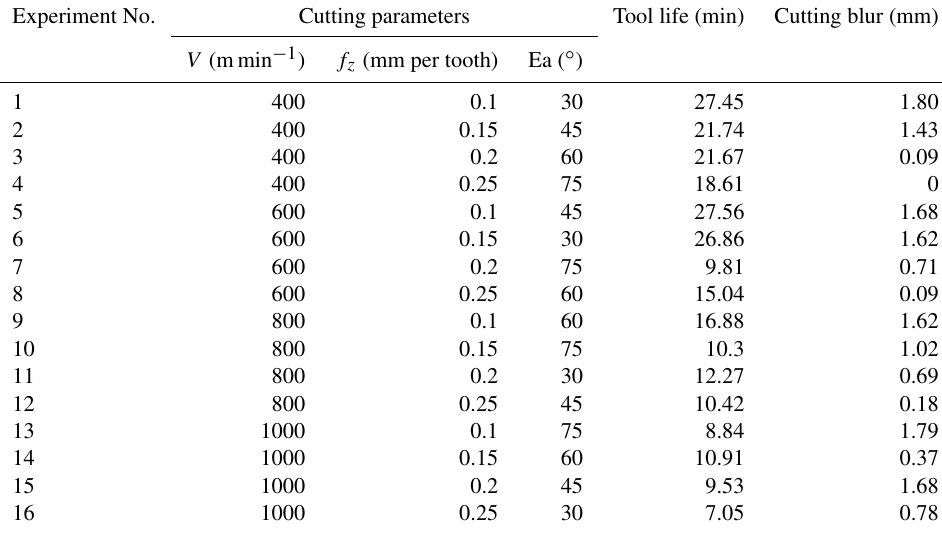
Table 3. Experimental data set used for training. Experiment No. Cutting parameters Tool life (min)